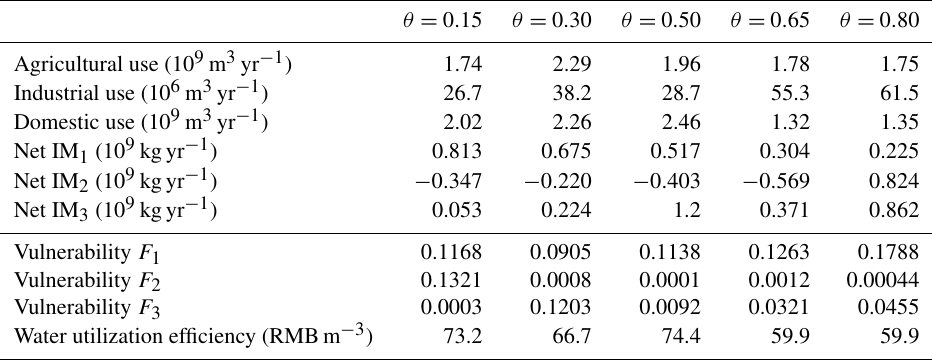
Table 7. Optimal solutions under varying water market prices.